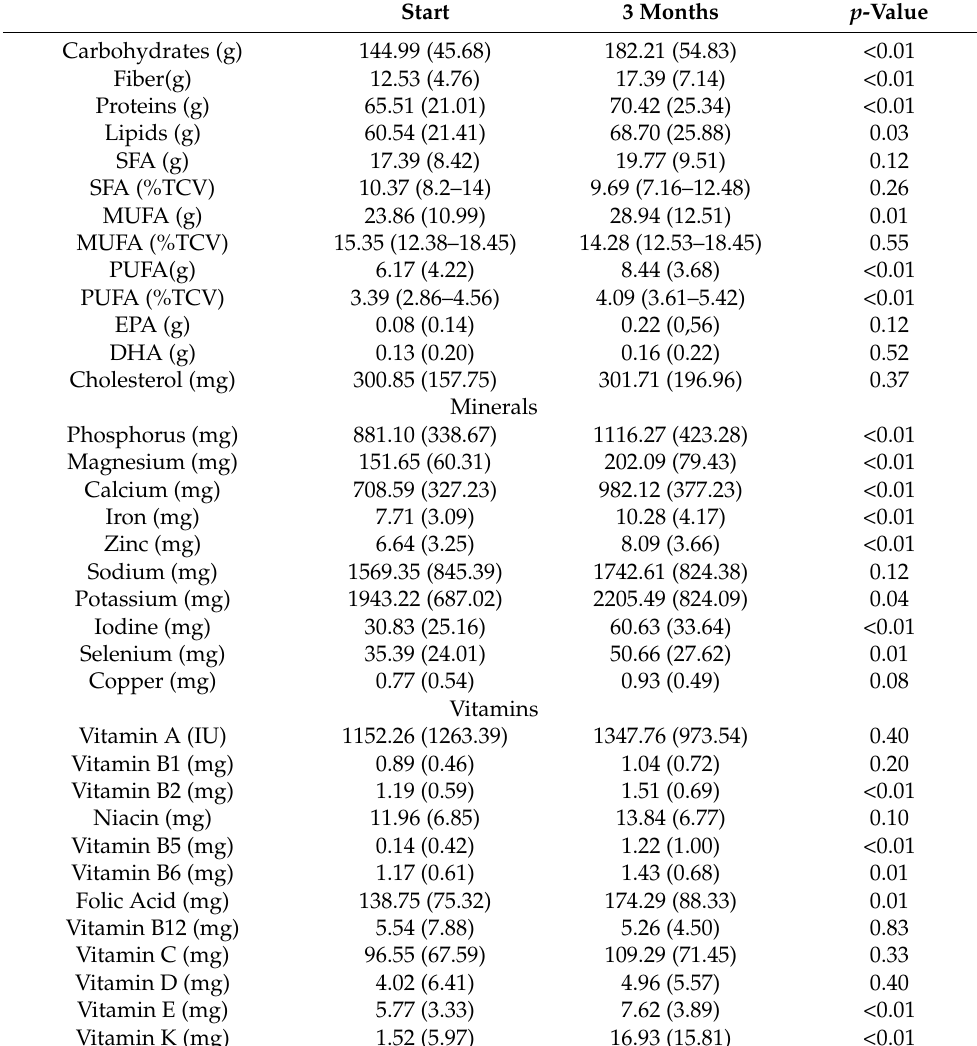
Table 5. Changes in macronutrients and micronutrients and their distribution before and 3 months after